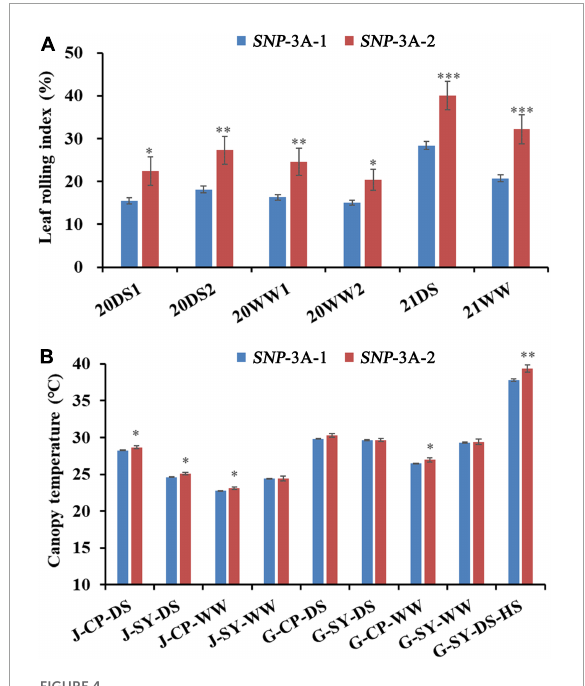
FIGURE4 Comparisons of LRI (leaf rolling index), and CT (canopy temperature) in the two TaMYB5-3A genotypes SNP -3A-1 and SNP -3A-2. (A) LRI comparisons of two TaMYB5-3A genotypes in six environments. LRI data were collected in 2020 and 2021; 20, 2020; 21, 2021; DS, drought stress; WW, well-watered; 1 or 2 after 20DS or 20WW refers to two replicates set for each treatment, respectively. (B) CT comparisons of two TaMYB5-3A genotypes in nine environments. CT data were collected in 2017. Plant growth stages: J, jointing stage; G, grain-filling stage. Planting locations: CP, Changping, SY, Shunyi. Treatments: DS, drought stress; WW, well-watered; HS, heat stress. The significance of data differences is tested by Student’s t